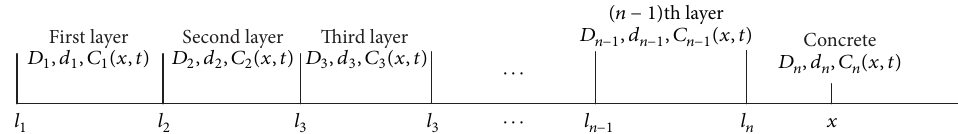
Figure 3: Concrete with ( 𝑛 − 1 ) layers of